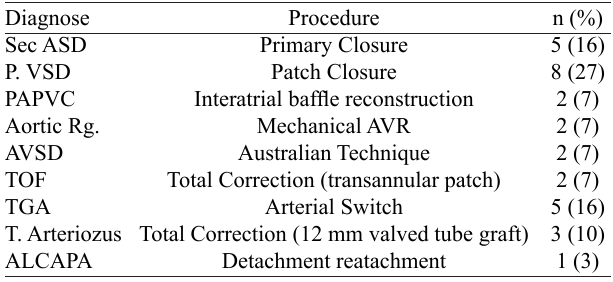
ASD: Secundum type atrial septal defect, P. VSD: Perimembranous type ventricular septal defect, PAPVC: Partial abnormal pulmonary venous connection, AVSD: Atrio ventricular septal defect, TOF: Tetralogy of fallot, T. Arteriozus: Truncus arteriozus, ALCAPA: Abnormal left coronary artery from pulmonary